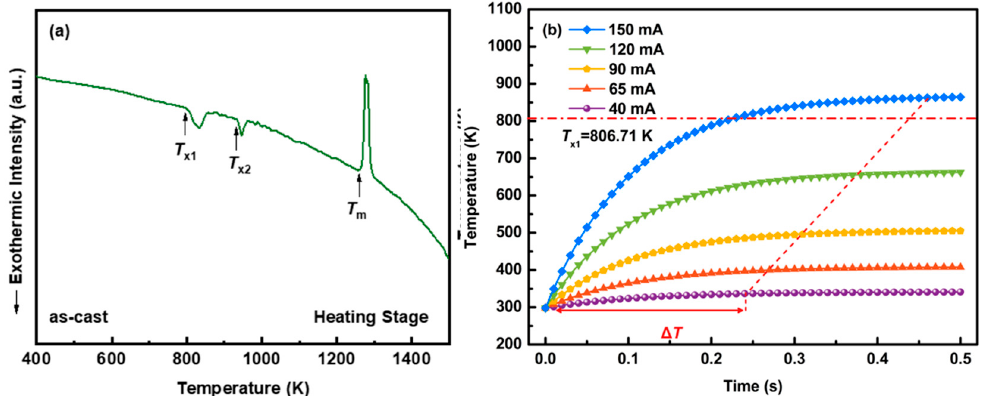
Figure 2. Determination of direct current-annealing strength: ( a ) DSC curve of as-cast metallic Co-based microwires; ( b ) Temperature rising at 0–0.5 s under different current intensities based on numerical calculation of transient temperature rise.